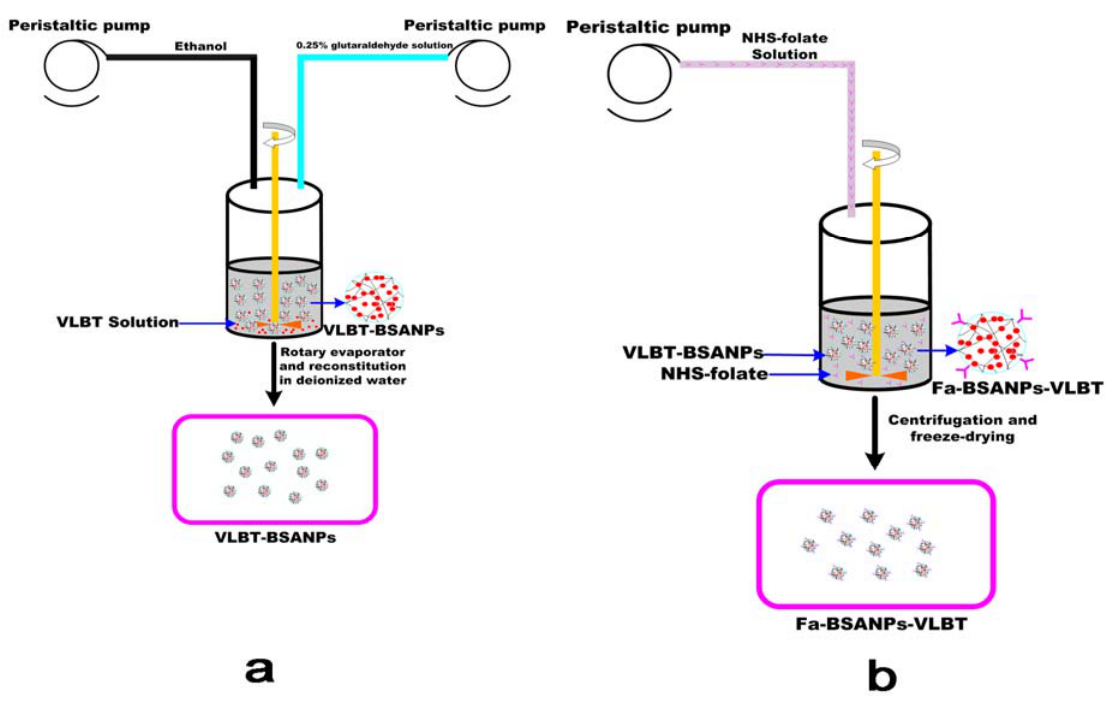
Figure 9. Schematic description of the preparation procedure of Fa-BSANPs-VLBT: ( a ) VLBT-BSANPs were produced with a desolvation technique; ( b )